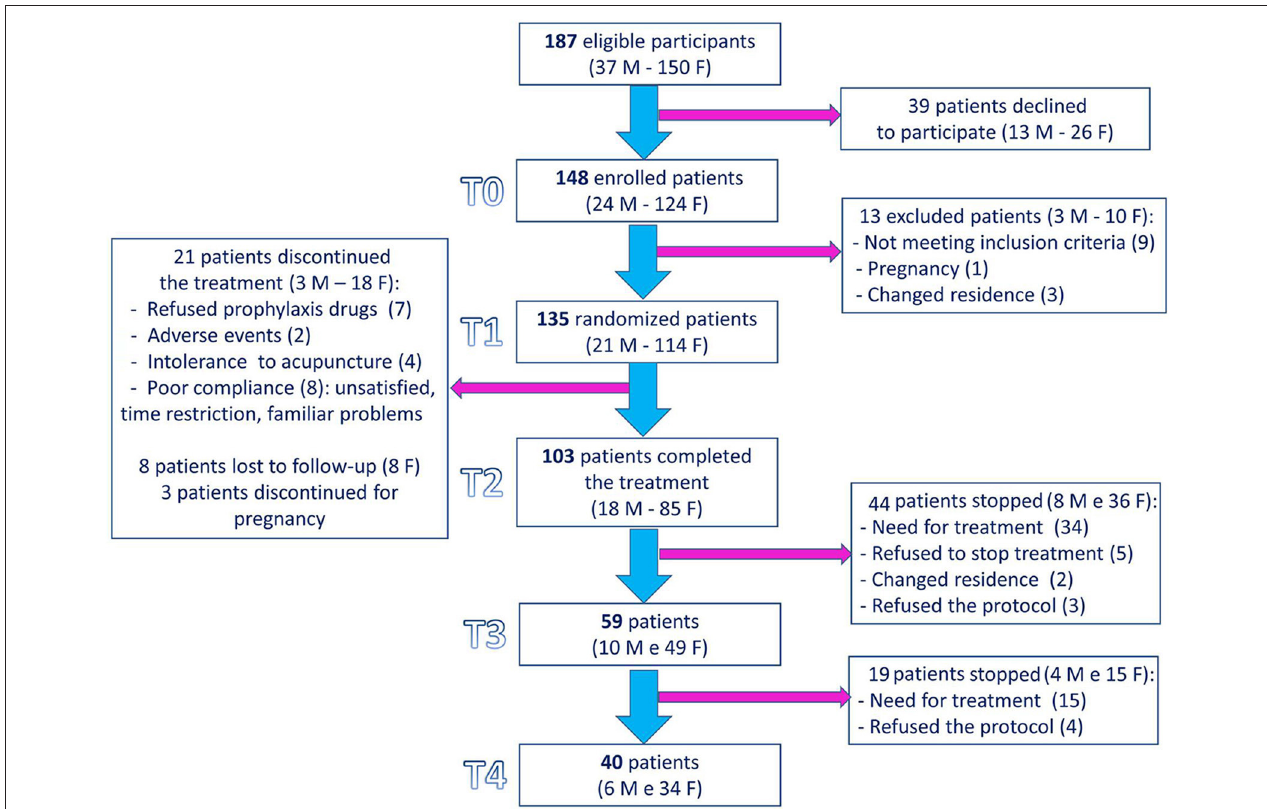
FIGURE 2 | Study flowchart. F: females; M: